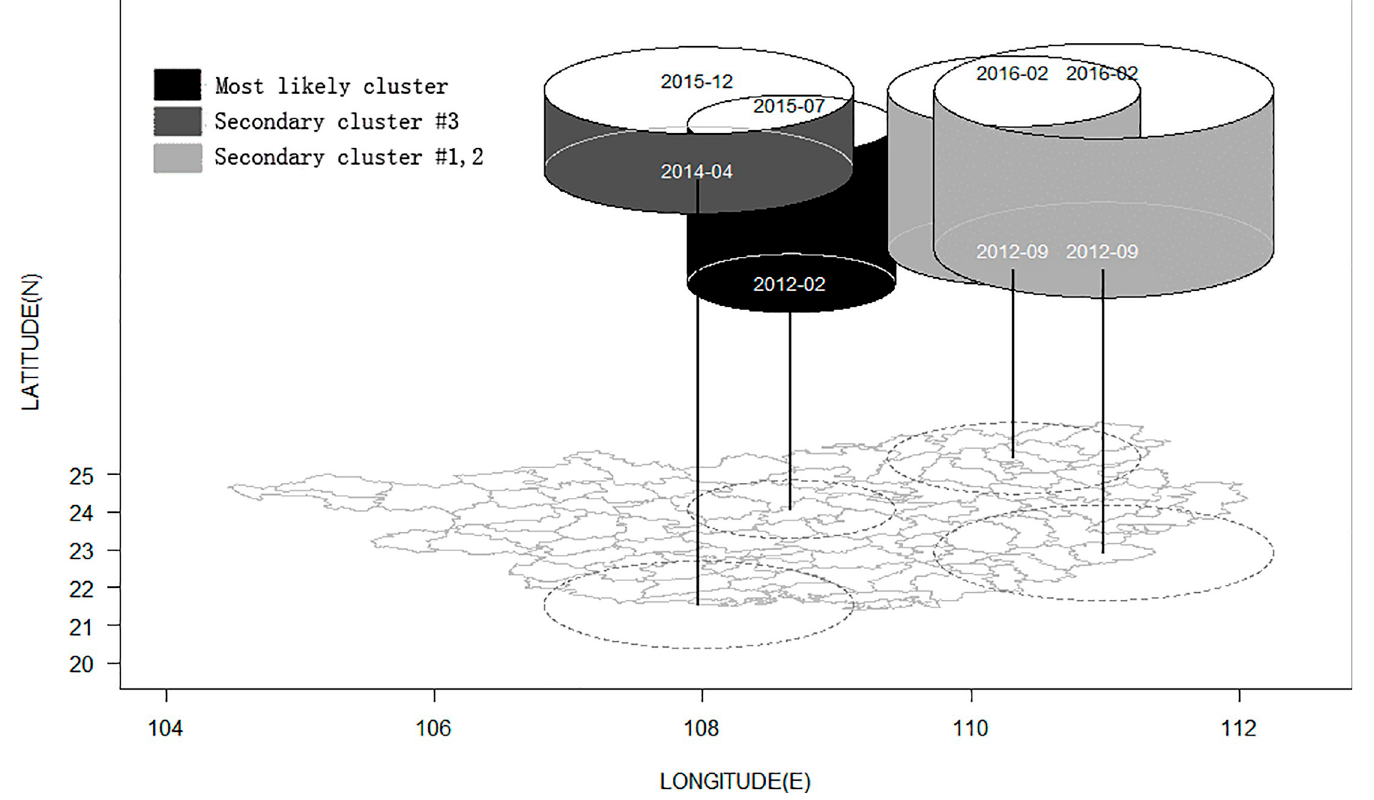
Fig 3. 3D cluster window of TB notification based on space-time scan in Guangxi, 2010–2016.